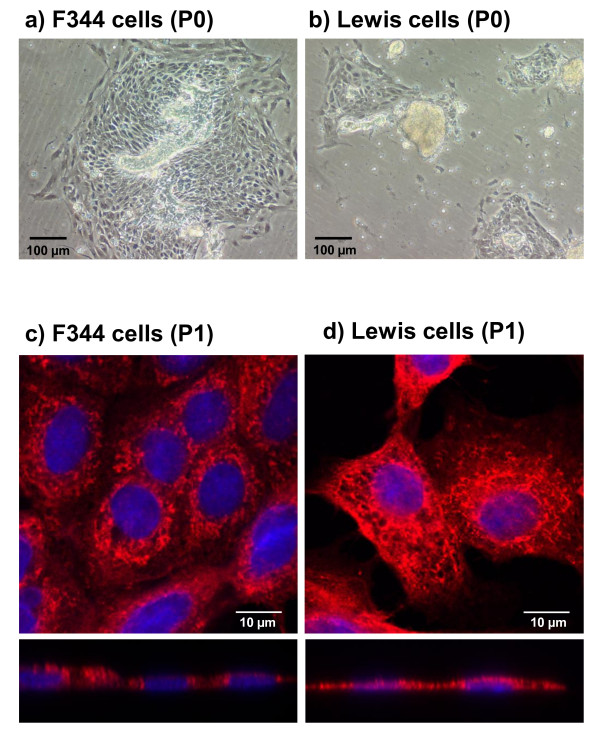
Differences in cultures of primary mammary cells from F344 and Lewis rats and cellular localization of α-amylase. One day after preparation, epitheloids from F344 (a) showed a faster and better attachment and a more effective growth in comparison to those from Lewis rats (b). Detection of α-amylase (Cy3; red) was performed in mammary gland cells from F344 (c) and Lewis (d) rats (P1). Nuclei were stained with DAPI (blue). Pictures show cells in xy- and xz-axis by confocal microscopy. α-Amylase was present in F344 and Lewis cells. However, in Lewis cells, α-amylase was distributed throughout the whole cell, whereas in F344 cells it was found in a more granular manner near the nuclei (xz-axis).